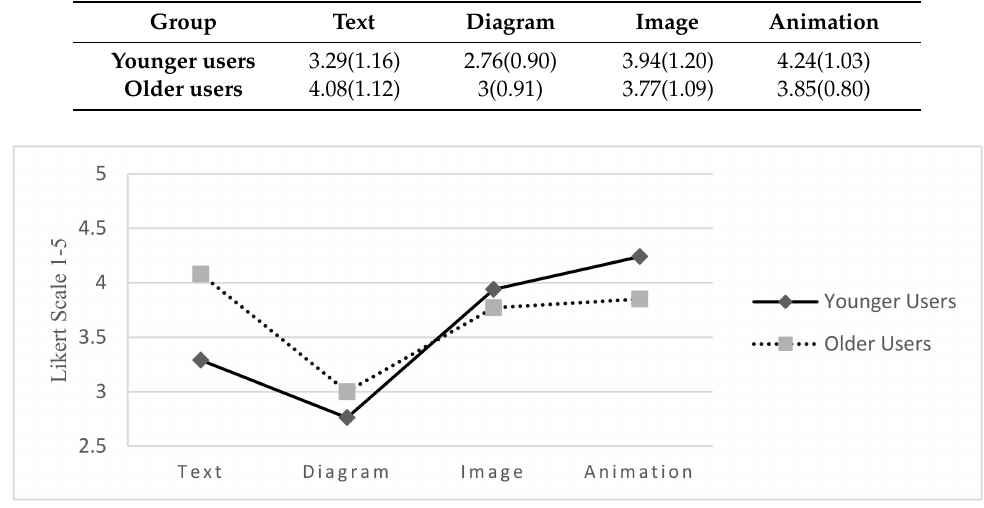
Figure 11. Comprehension comparison of the four